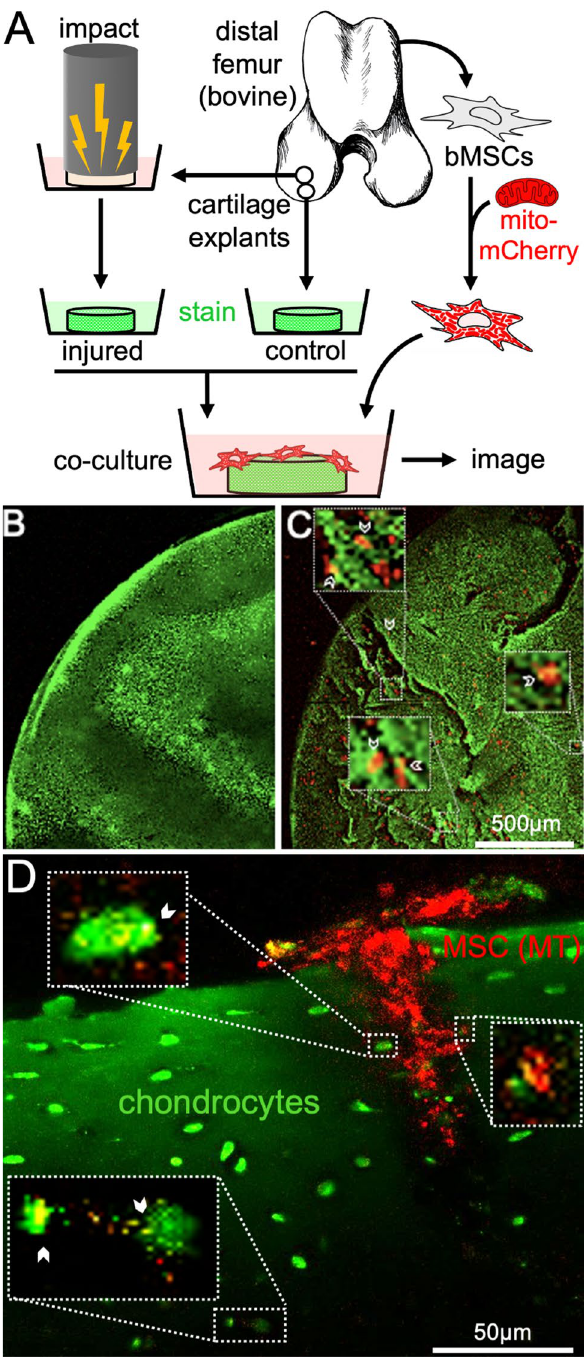
Figure 5. Bovine mesenchymal stromal cells (MSCs) home to damaged cartilage and transfer mitochondria (MT) to chondrocytes in situ. ( A ) Schematic depicting experimental design for cartilage explant injury. ( B ) Representative image of unimpacted cartilage explant stained with carboxyfluorescein diacetate (green) and seeded with lentiviral transduced mCherry-mito MSCs (red MT) compared to ( C ) injured cartilage seeded with MSCs and cultured for 4 days. MSCs localized to damaged areas on injured cartilage, while MSCs were not present on the surface of uninjured cartilage. ( D ) High magnification images of MSC (red MT) localized deep within a crack in injured cartilage (articular surface is toward the top). MSC interactions with chondrocytes (green) are evident in several locations (white arrowheads) and MT transfer is evident in areas of red + /green + co-localization (yellow) close to the crack (top insets) as well as remote and deep to the crack (bottom